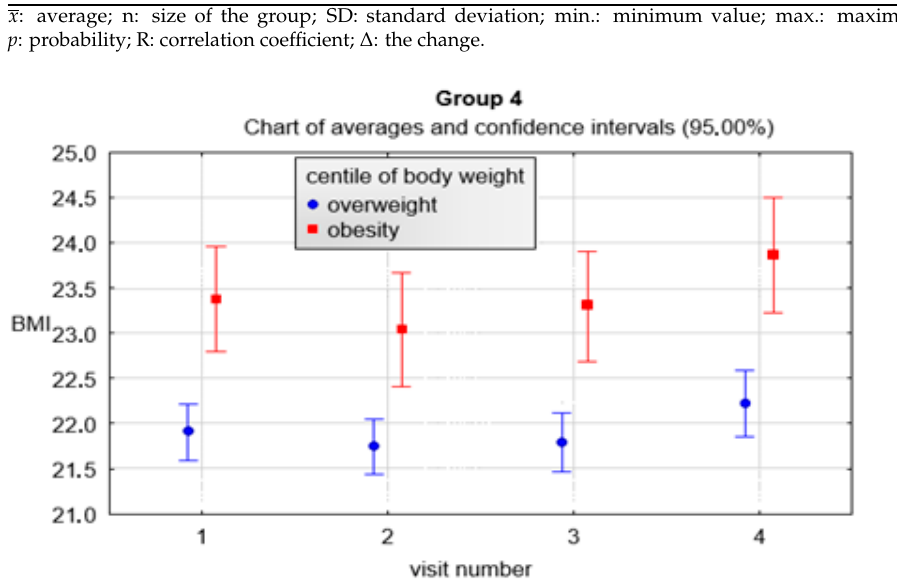
Figure 2. BMI in children with overweight and obesity at consecutive visits.